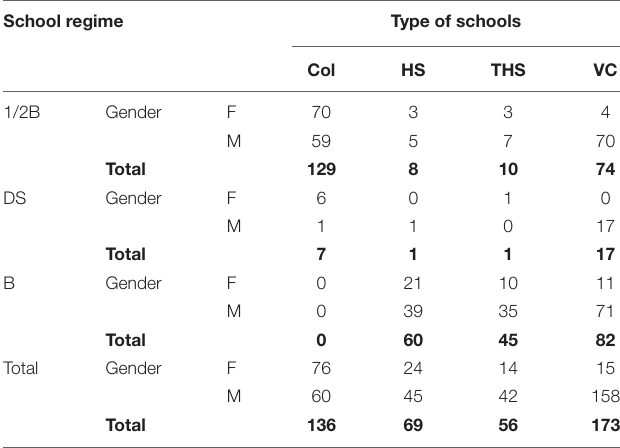
TABLE 1 | Descriptive data according to the school regime, to the gender and the type of